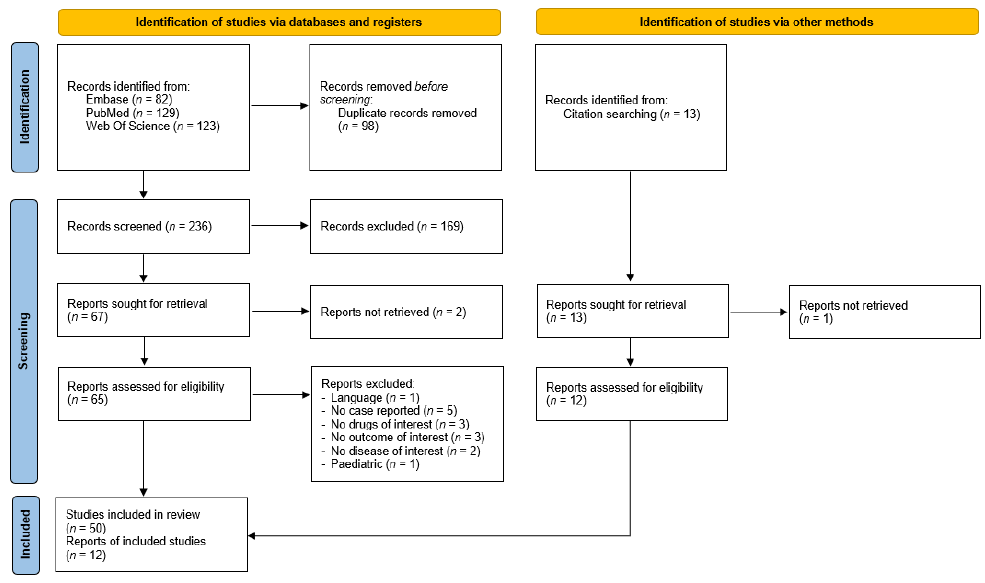
Figure 2. PRISMA Flow.